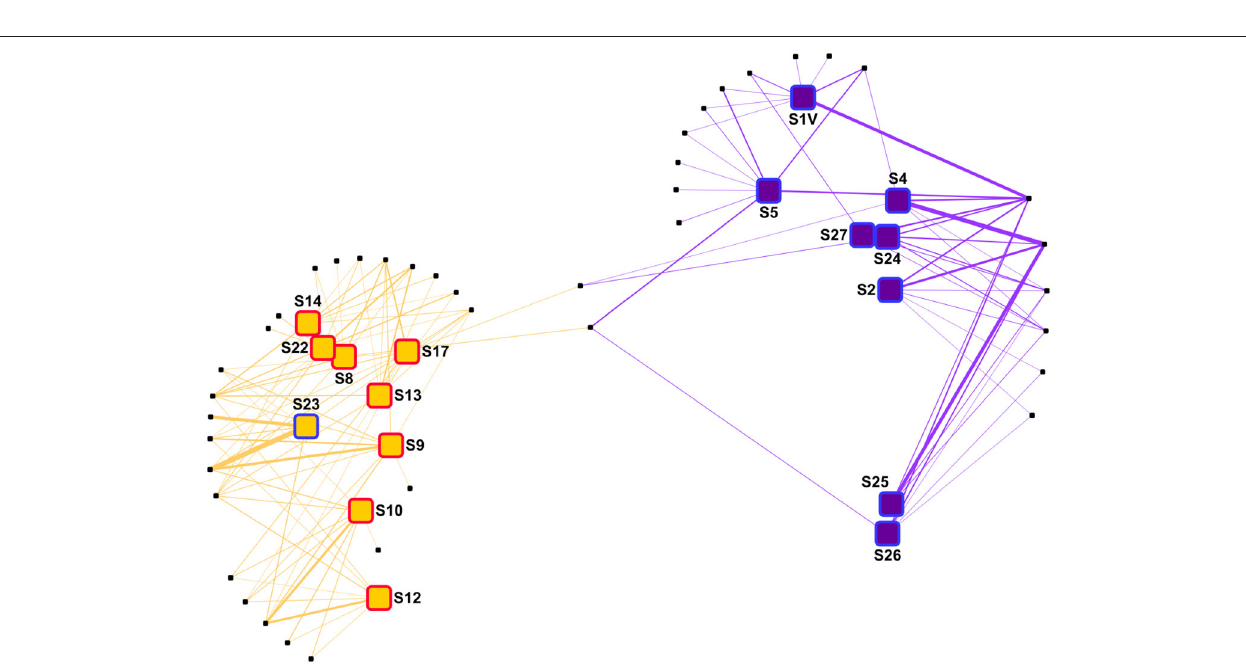
FIGURE 7 | Network analysis of the virus samples. The samples were distributed using a “force-directed” paradigm on viral OTU distributions. The width of the edges represent the abundance of the OTU within a sample. Purple squares, group V1 samples; orange squares, group V2 samples; red border, plume sample; blue border, background